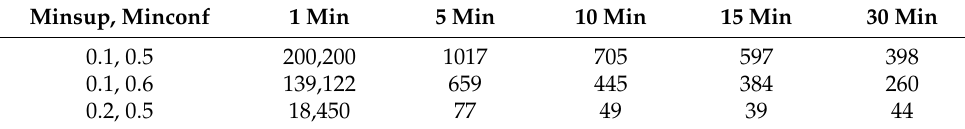
Table 2. Number of association rules for each temporal type at different support and confidence levels.